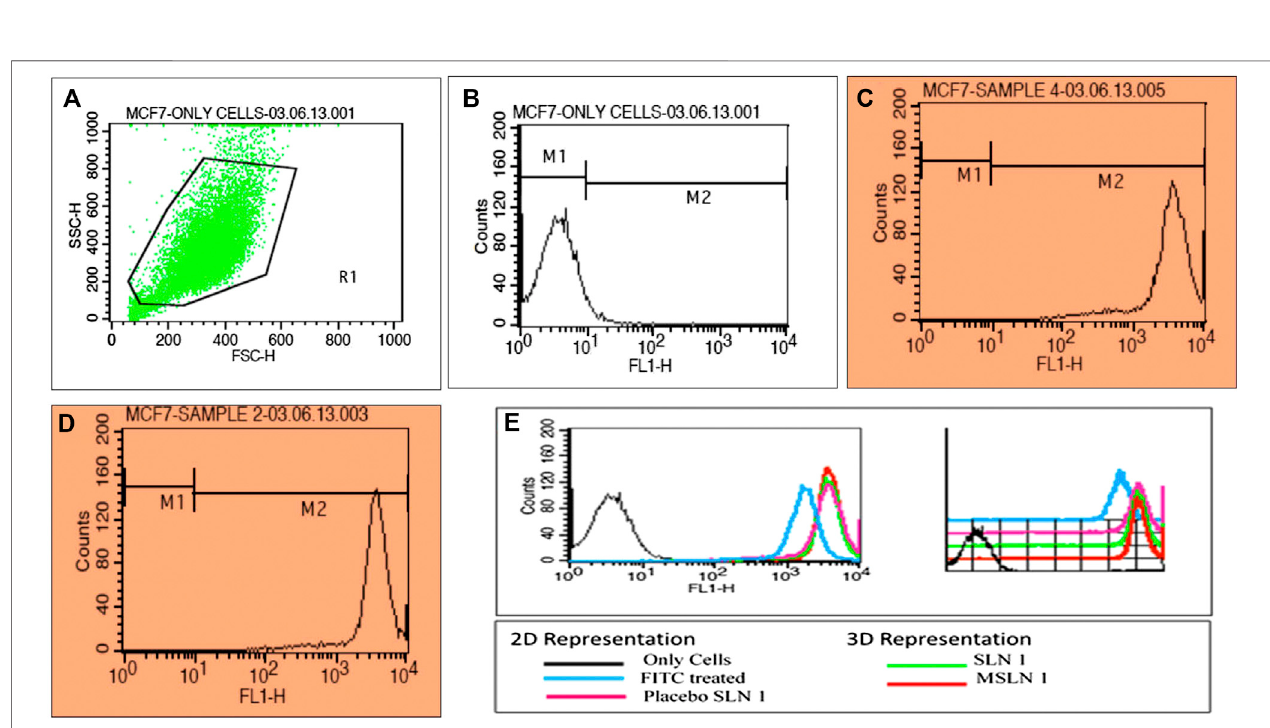
FIGURE 7 | Cell uptake results of developed SLN formulations by fl ow cytometry. (A) Uptake by MCF-7 cells, (B) uptake by untreated MCF-7 cells, (C) uptake of D-SLN by MCF-7 cells, (D) uptake of SMD-SLN by MCF-7 cells, and (E) fl ow cytometry analysis 2D and 3D representation.